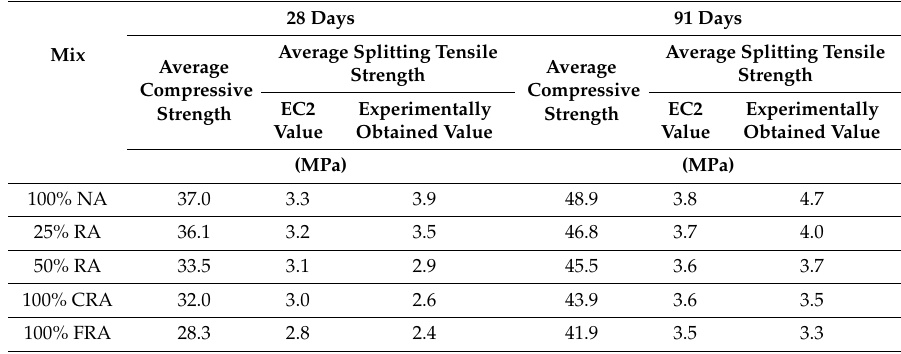
Table 9. Splitting tensile strength versus compressive strength determined according to EC2 [32] at 28 and 91 days (PC 45).